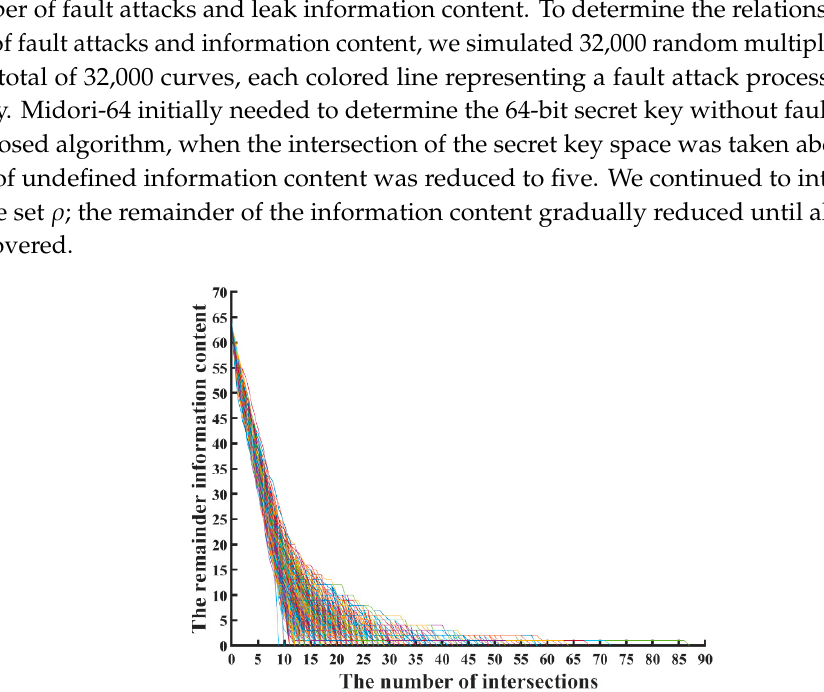
Figure 8. The remaining information content in 32000 fault attacks.